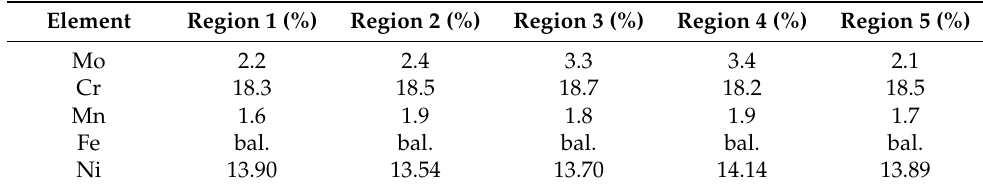
Figure 4. ( a ) Cross-sectional SEM analysis, yellow rectangle corresponding to the region magnified ( b , c ) the hierarchical and fine columnar microstructure with a few small pores and inclusions. SEM–energy-dispersive X-ray spectroscopy (EDX) mapping of the chemical composition for the corresponding yellow rectangle shown for Cr, Mn, Mo and Ni elements, showing well distributed alloying elements. Red starts corresponding to place where point EDX analysis were done and summarized in Table 1. Table 1. EDX–SEM compositional analysis (wt.%) of the regions shown in Figure 4b (standard deviation 0.3–0.5